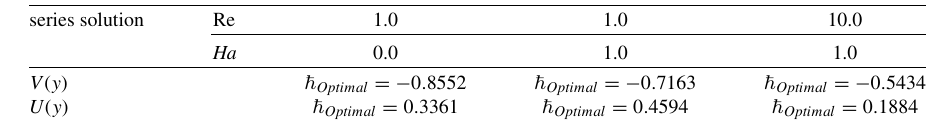
Table 1 The optimal values of (cid:1) for different values of Re and Ha